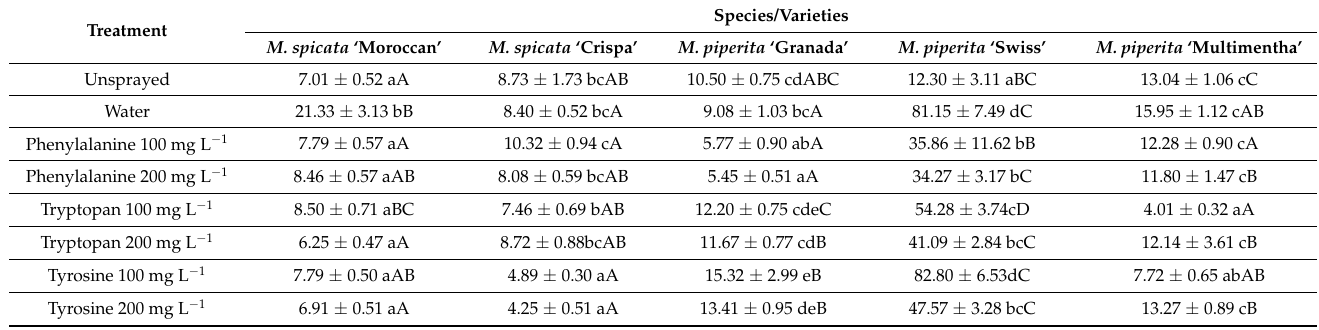
Table 2. Rutin content in mint influenced by foliar application of amino acids, mg 100 g − 1 DM in